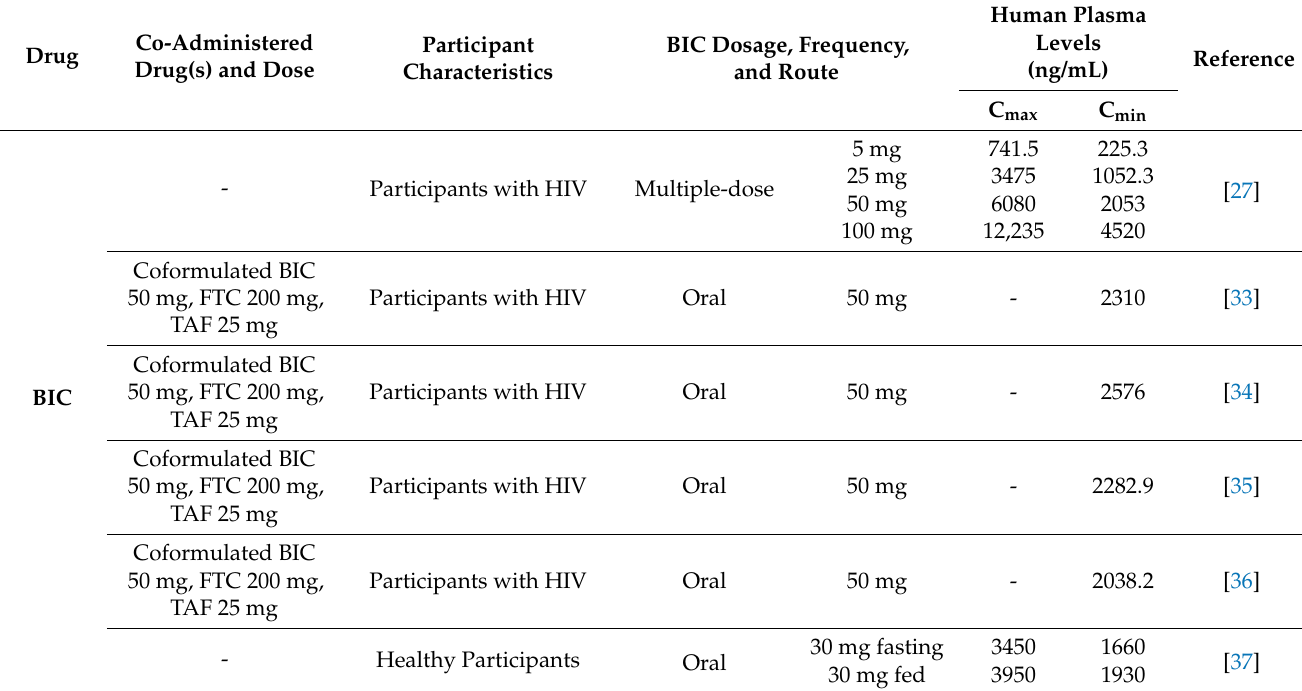
Table 3. Literature review of HIV BIC pharmacokinetic studies in